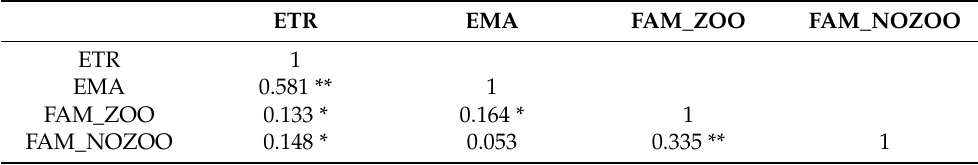
Table 3. Correlation matrix. The correlation matrix was used to test the hypothetical relationship pat- tern among selected key drivers. The results provide indications of statistically significant correlation between Ethical responsibility with all other variables, moderate positive correlation with Emotional appeal, r (263) = 0.581, p < 0.01, and small correlation with Familiarity zoo-related r (239) = 0.133, p < 0.05 and Familiarity not zoo-related r (235) = 0.148, p < 0.05. * Pearson Correlation p < 0.05 level (2-tailed). ** Pearson Correlation p < 0.01 level (2-tailed). ETR EMA FAM_ZOO FAM_NOZOO ETR 1 EMA 0.581 ** 1 FAM_ZOO 0.133 * 0.164 * 1 FAM_NOZOO 0.148 * 0.053 0.335 **